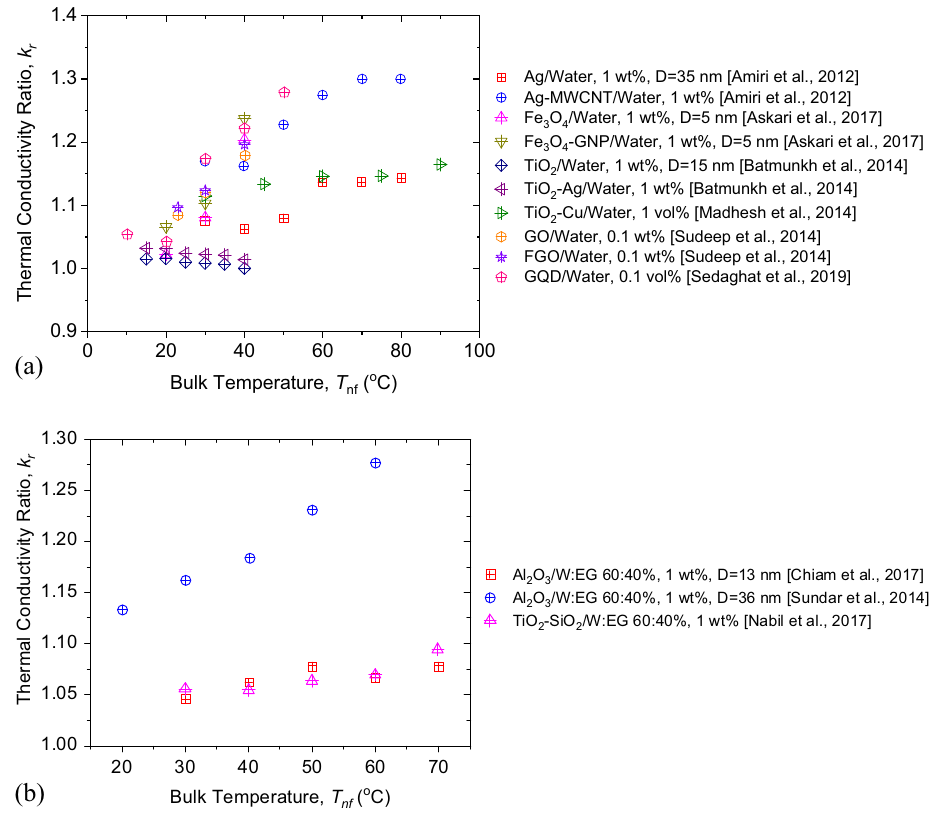
Figure 5: E ff ect of bulk temperature: ( a ) water and ( b ) W:EG